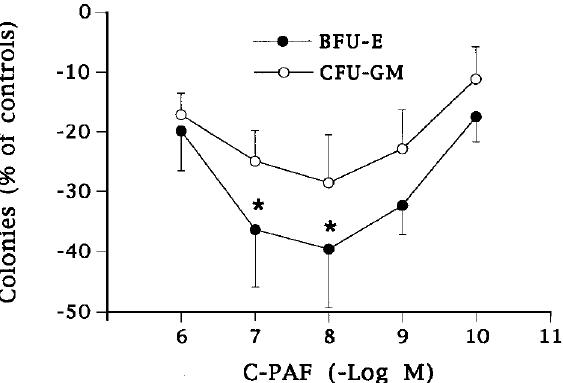
FIG. 1. Direct effect of C-PAF on the number of BFU-E and CFU-GM colonies derived from freshly isolated marrow CD34 + cells. Percentage of variation of colony numbers compared with control values (seven independent experi- ments). * P < 0.01 (Wilcoxon’s test). Colony numbers in controls were 37 ± 7 and 85 ± 11 for BFU-E and CFU-GM, respectively.